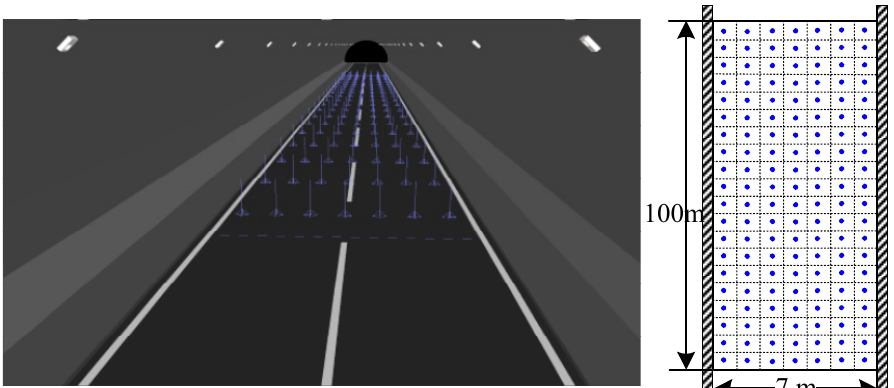
Figure 10. Pavement illumination simulation points.